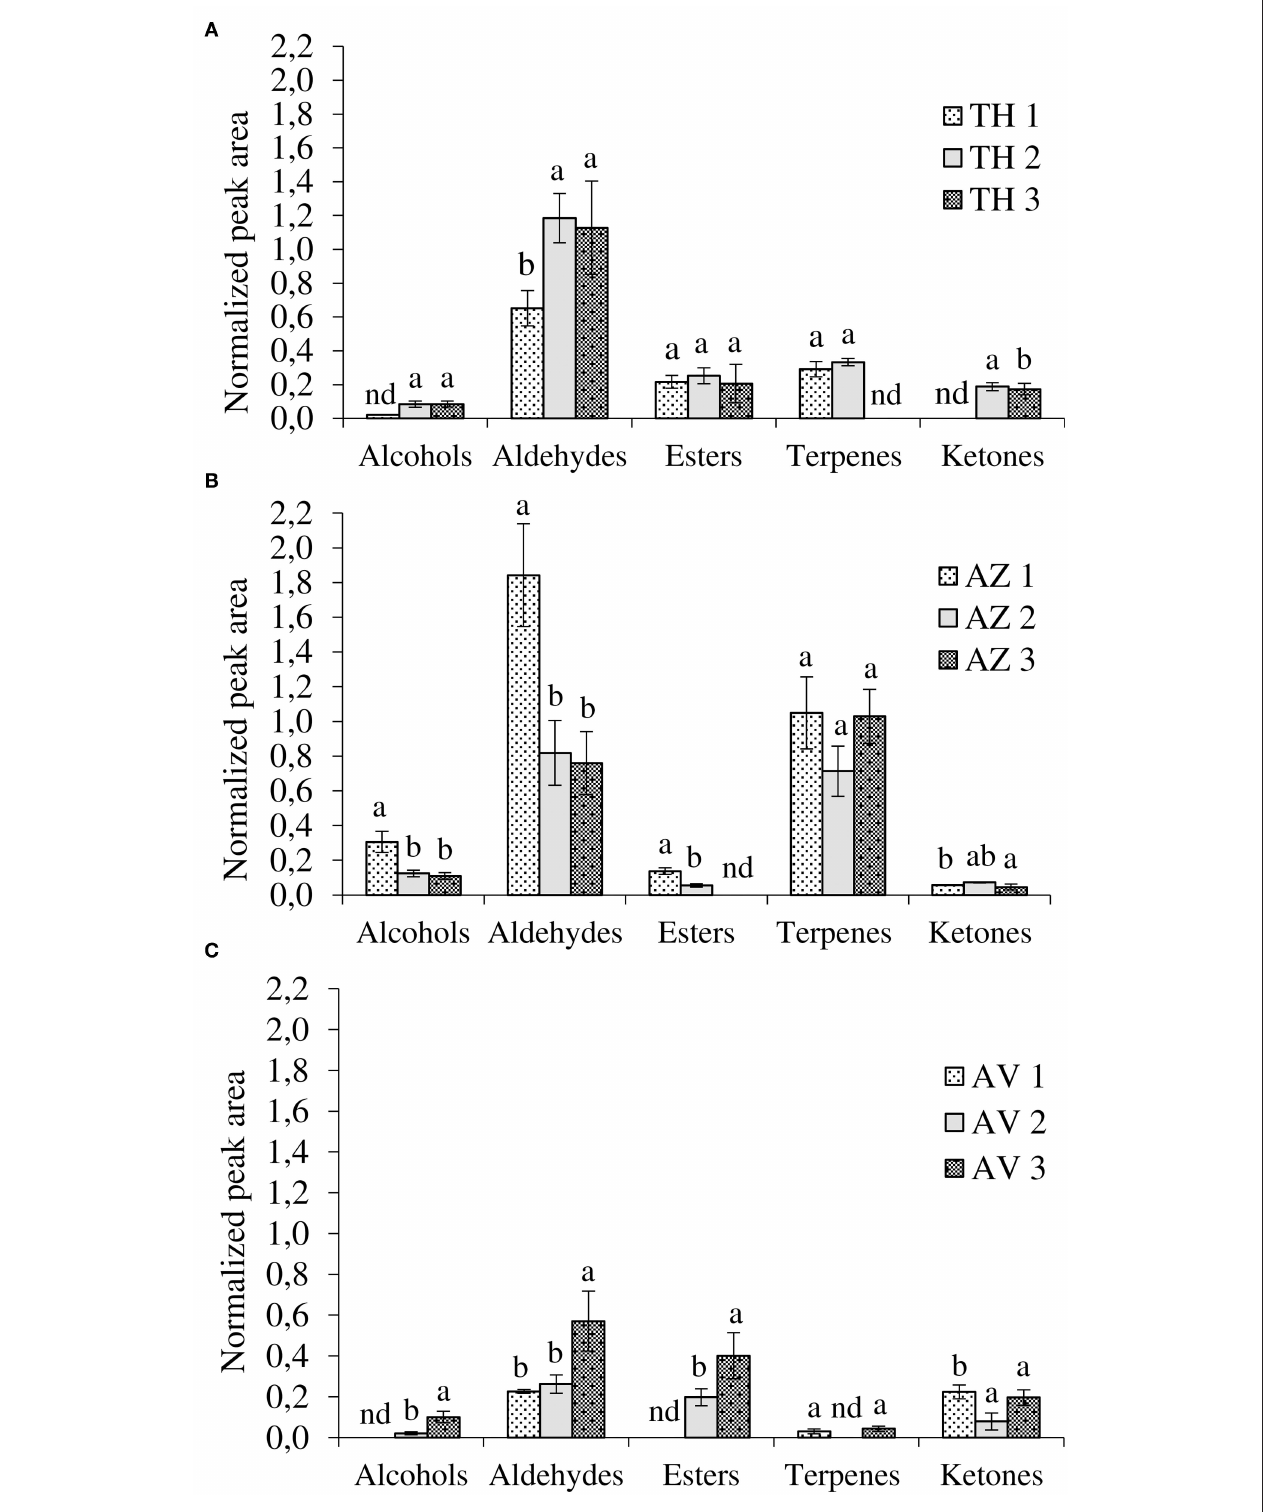
FIGURE 3 | Evolution of volatile compounds during ripening according to chemical classes. (A) Taamriwthe, (B) Azegzaw, and (C) Averkane; 1, unripe figs; 2, ripe figs; 3, fully ripe figs; nd, not detected. Results for each VOC group from the same cultivar with different letters are statistically different (ANOVA-LSD test; P < 0.05; a > b).